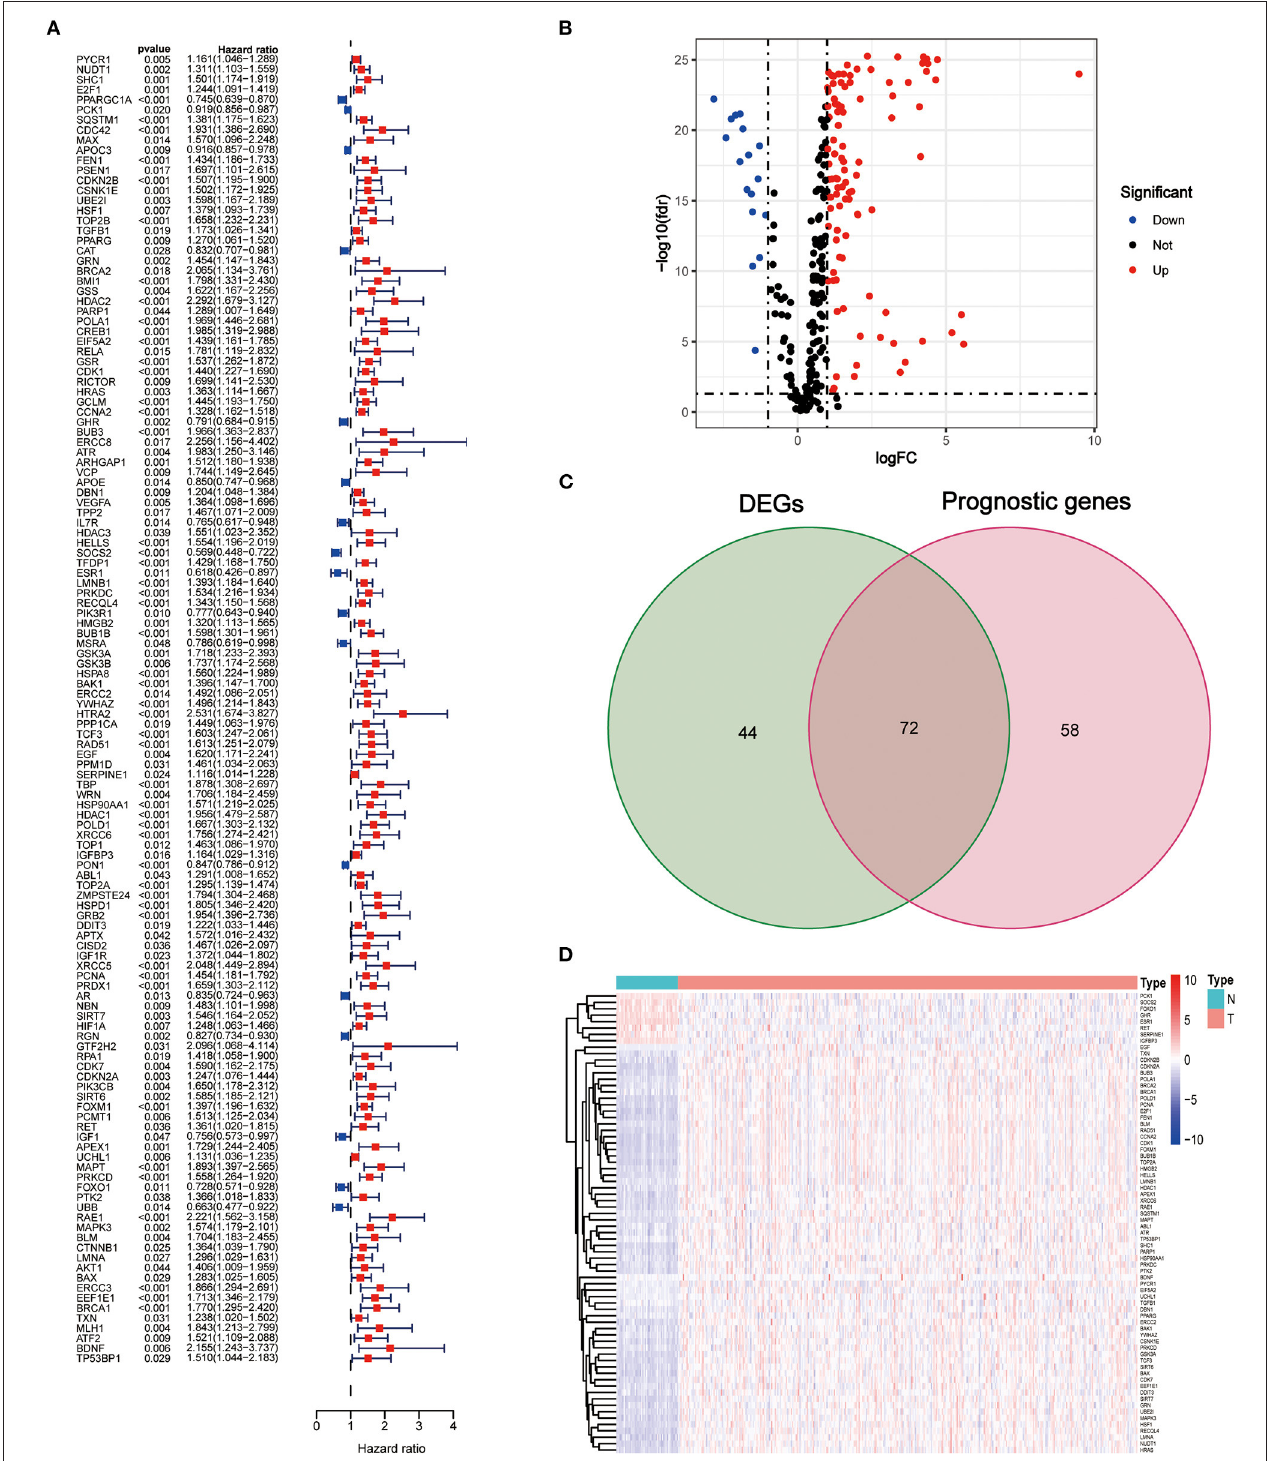
FIGURE 1 | Identification of interaction aging-related genes (AGs) between differential expression and prognosis. (A) Forest plots of the results of the univariate Cox regression analysis of OS. (B) Volcano plot of differentially expressed genes between tumor and adjacent normal tissue. (C) Venn diagram of the interaction AGs between differential expression and prognosis. (D) Hierarchical cluster heat map of interaction AGs.